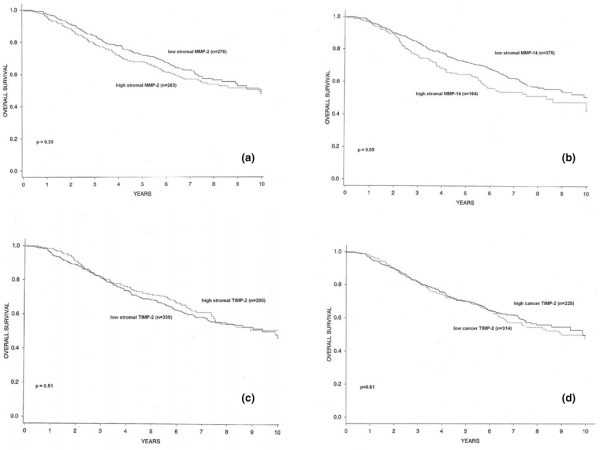
Overall survival for matrix metalloproteinase (MMP)-2, MMP-14 and tissue inhibitor of metalloproteases (TIMP)-2 expression by stromal and cancer cells. Overall survival curves for: (a) matrix metalloproteinase (MMP)-2 expressed by stromal cells; (b) MMP-14 expressed by stromal cells; (c) tissue inhibitor of metalloproteases (TIMP)-2 expressed by stromal cells; and (d) TIMP-2 expressed by cancer cells (p values obtained by the log-rank test).